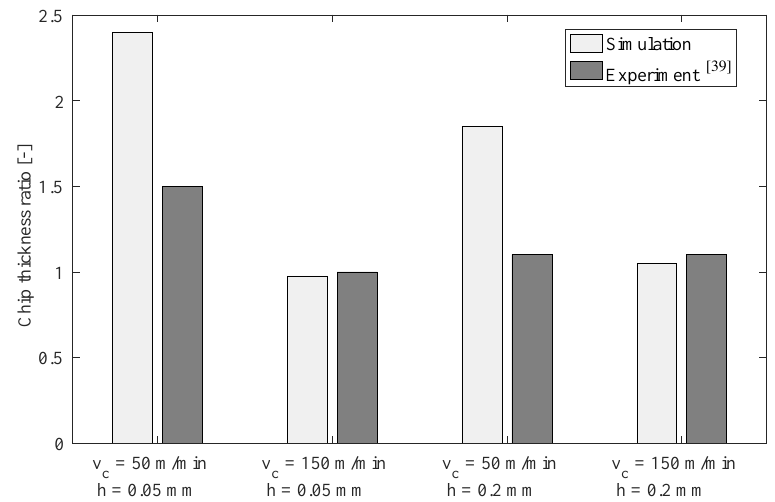
Figure 6. Experimental validation of chip thickness ratio.